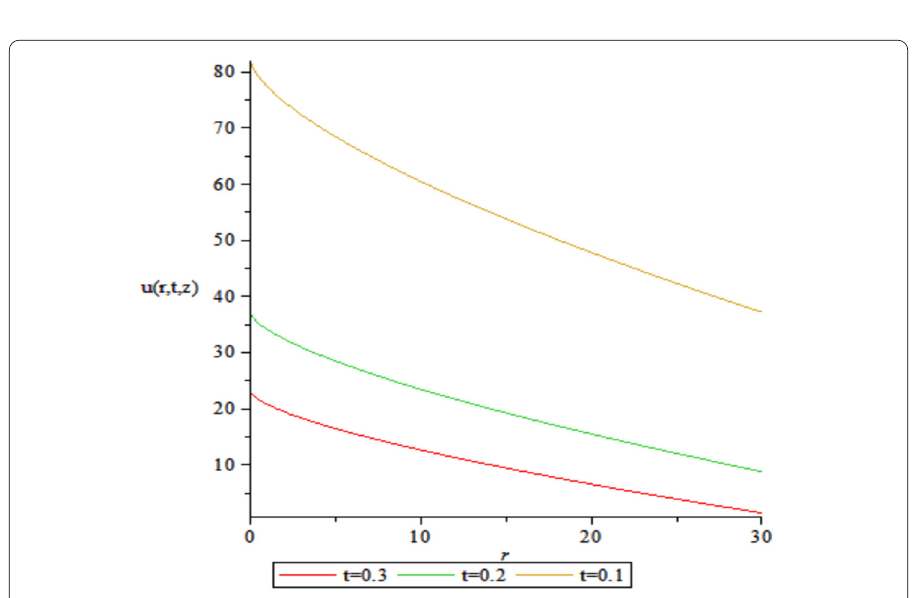
Figure 11 Velocity component u ( r , t , z ) at z = 5 and c 3 =